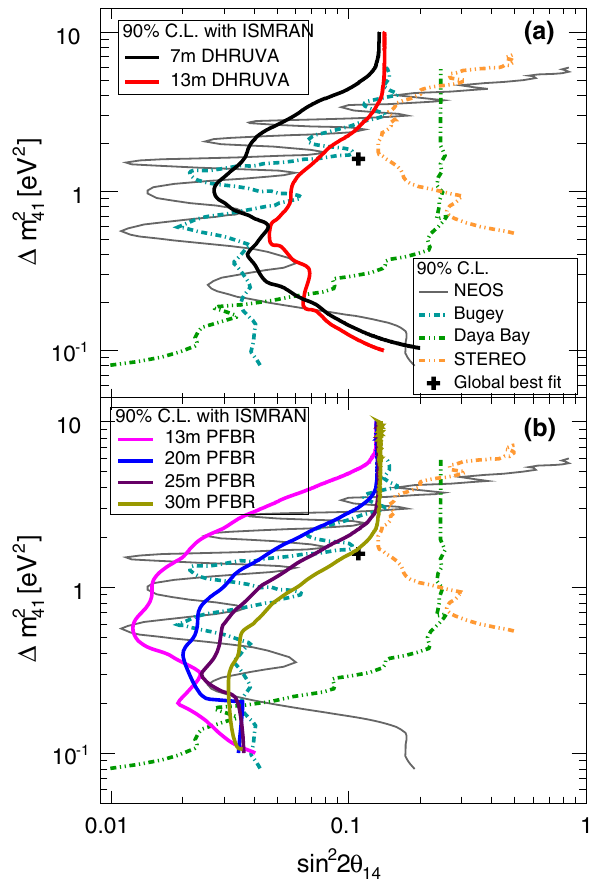
− 41 ( 1 − U ) 2 between ISMRAN e 4 e 4